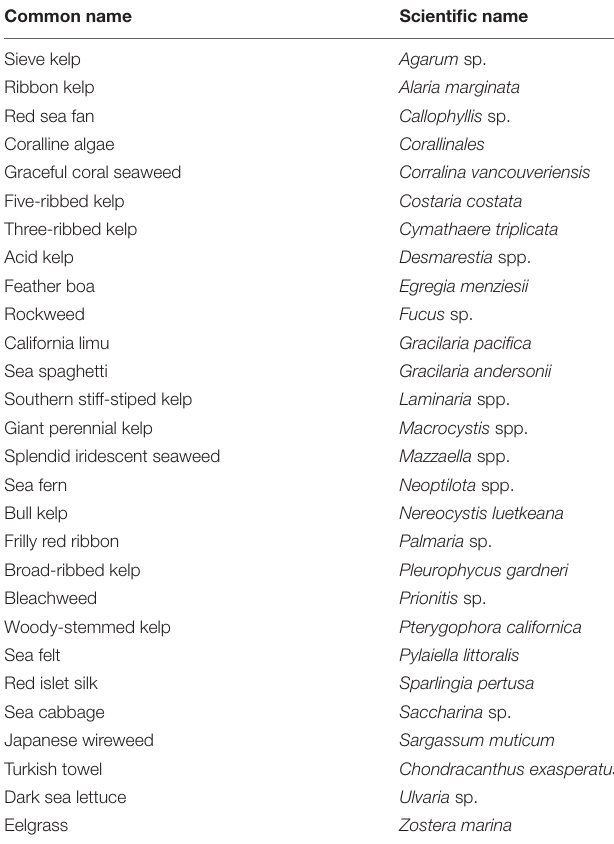
TABLE 2 | Documented macroalgae around Tl’ches